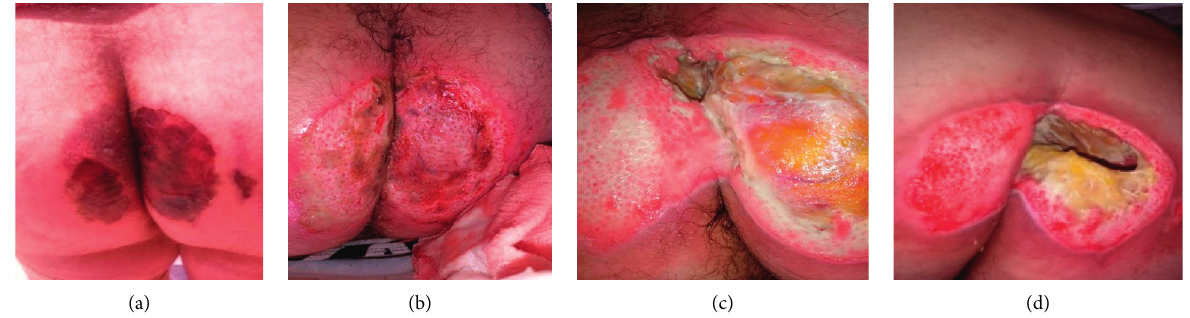
Figure 1: Wound progression before Curefini ® treatment. (a) Day 1: the patient is discharged from hospital after 27 days. Chloramphenicol/ collagen is initiated as local treatment. (b) Day 10: the first surgical debridement is performed. Chloramphenicol/collagenase local treatment continues. (c) Day 18: topical treatment with chloramphenicol/collagenase continues. (d) Day 20: the second surgical debridement is performed, initiated with iodoform gauze, antibiotics PO, and oral